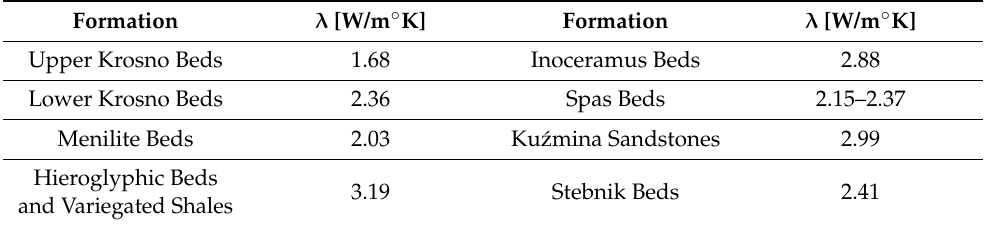
Table 5. Average thermal conductivity of the selected Carpathian rocks (K-1 borehole) [22,40]. Formation λ [W/m ◦ K]